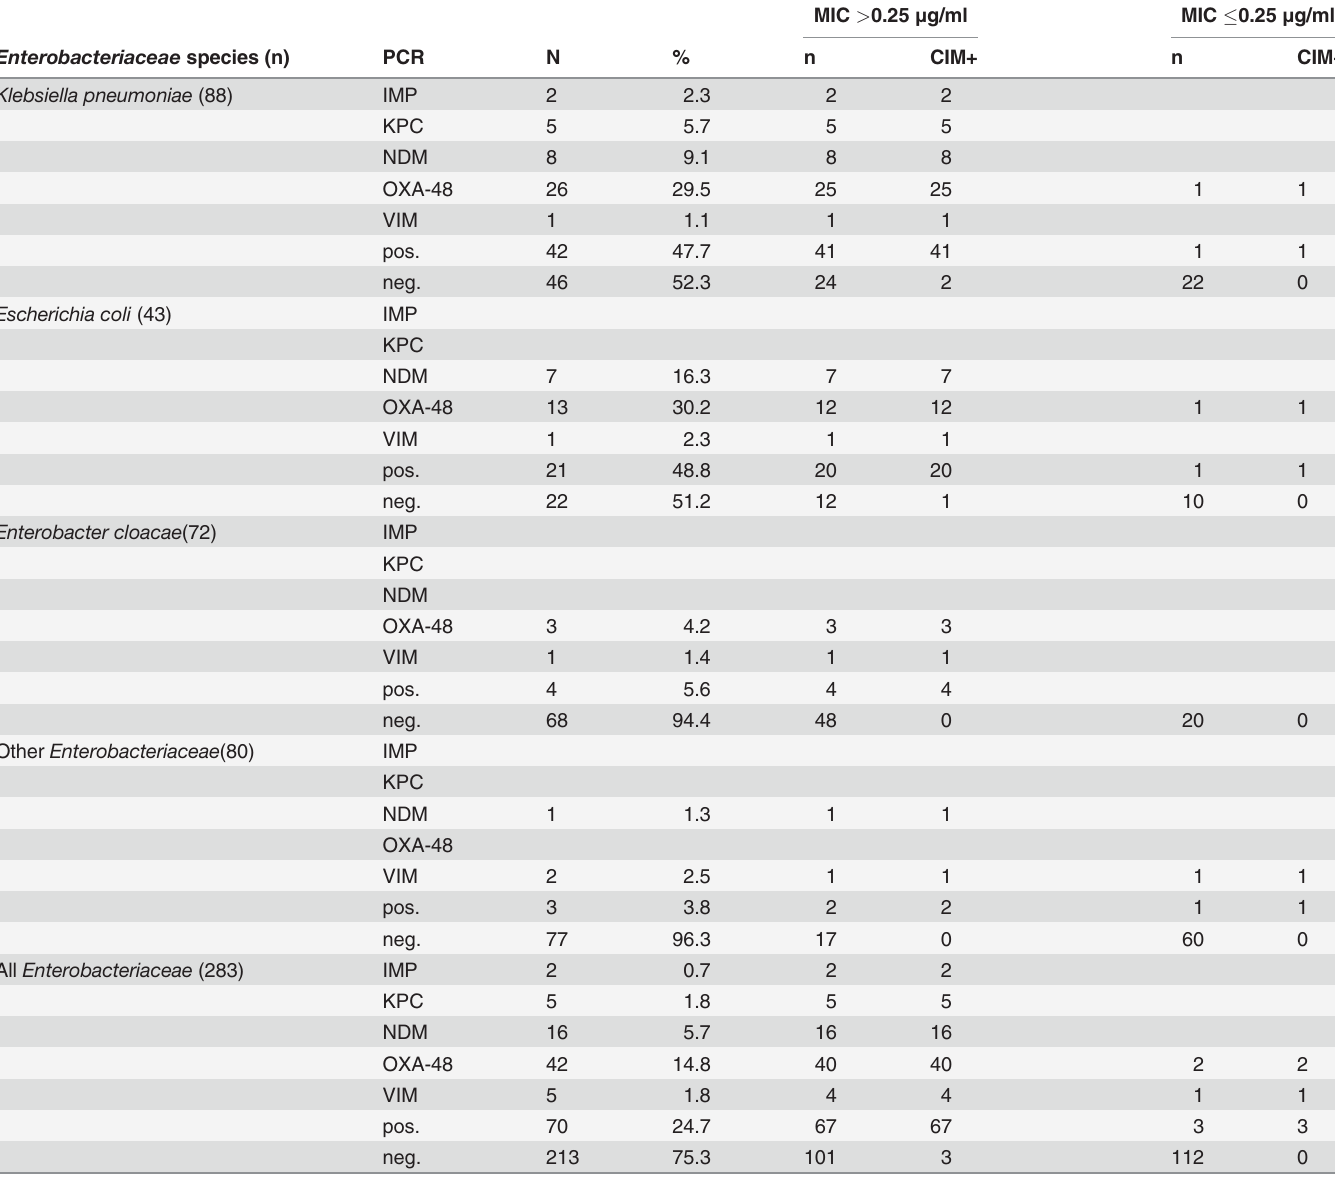
Table 2. Characteristics of Enterobacteriaceae isolates submitted for CPE surveillance during the first halves of 2012 and